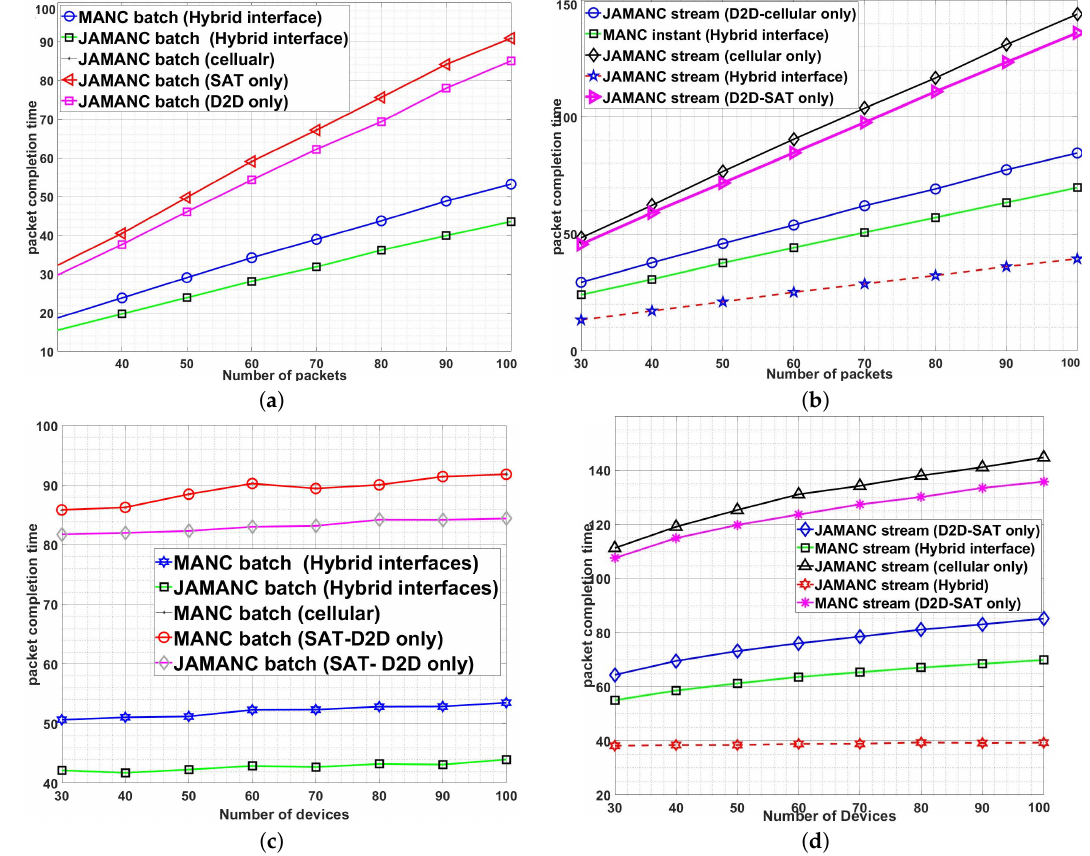
Figure 13. Mode analysis: Versus no. of packets/no. of devices. ( a ) Batch (versus no. of packets), ( b ) Stream (versus no. of packets), ( c ) Batch (versus no. of devices), ( d ) Stream (versus no. of